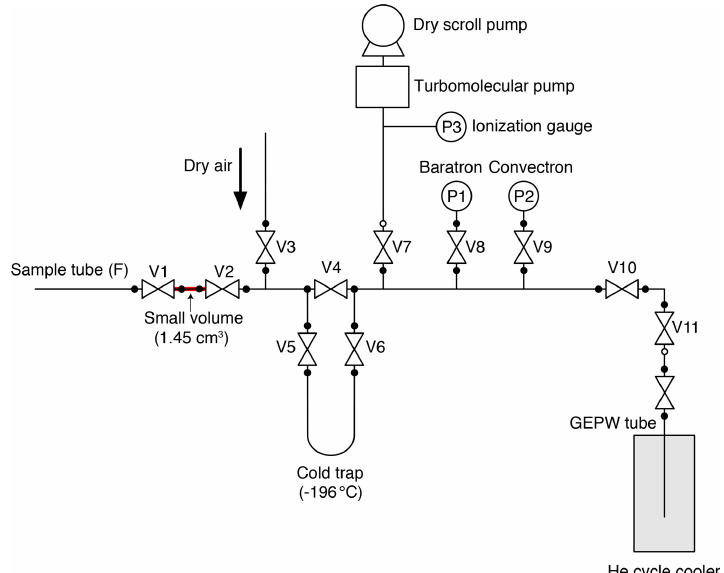
Figure 2. Schematic diagram of the split line.